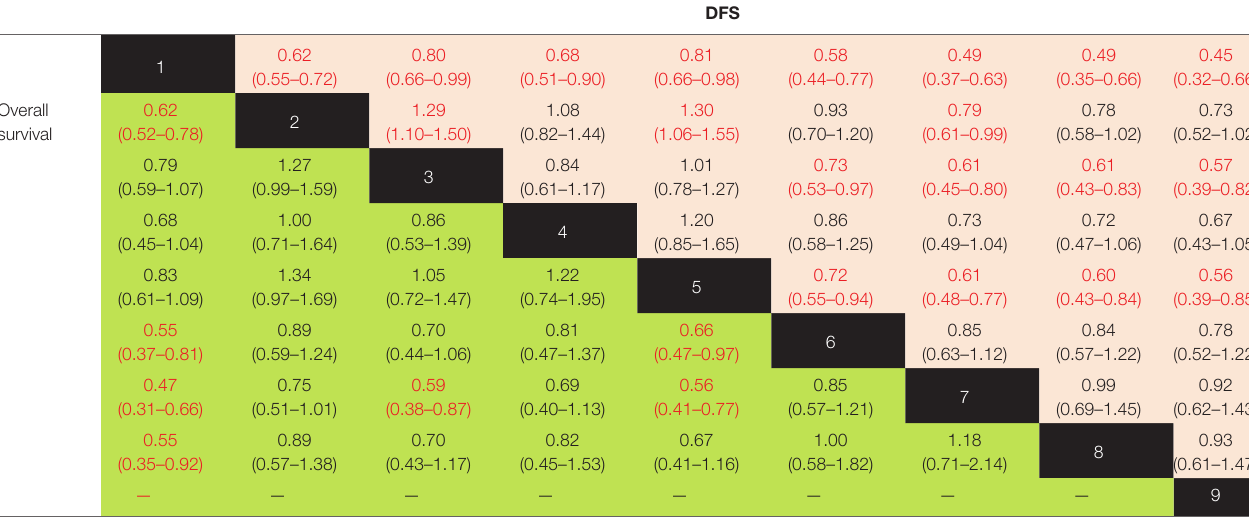
TABLe 2 | Mixed treatment comparison hazard ratios (HRs) and their respective 95% CrI for overall survival and disease-free survival (DFA) comparing the (neo)adjuvant treatment strategies available for early and locally advanced breast cancer.